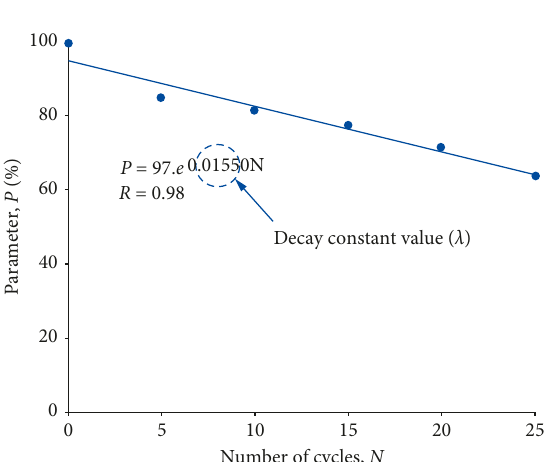
Figure 4: Determining the decay constant property ( λ ) from weathering processes